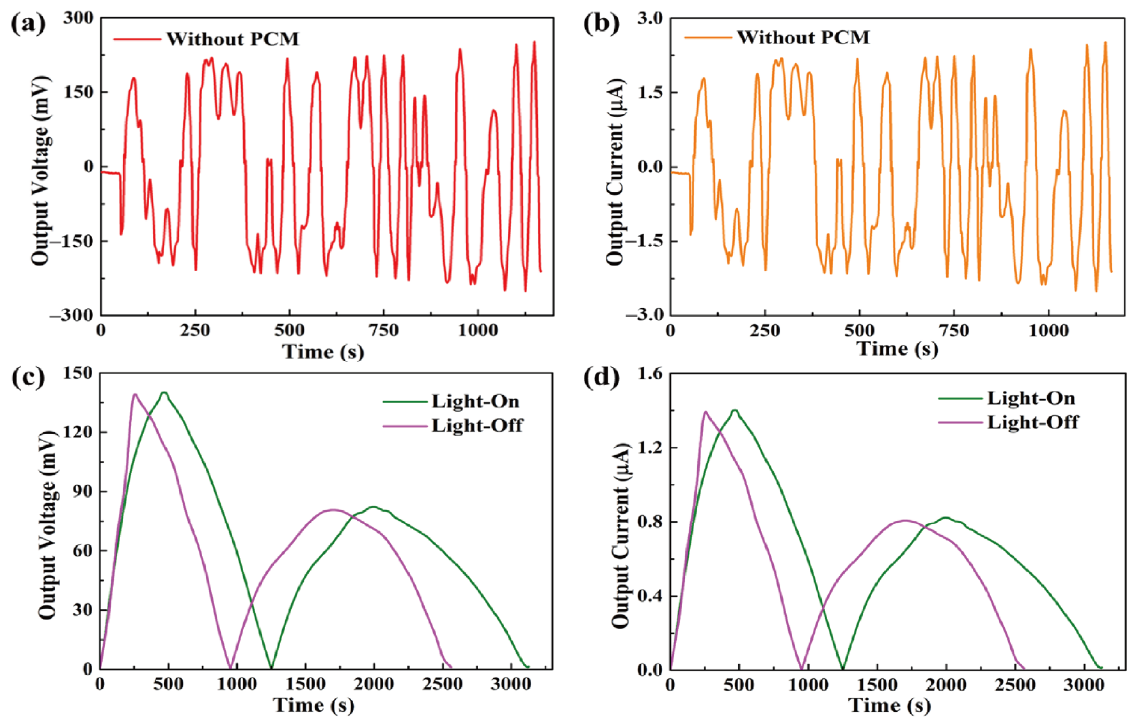
Figure 7. ( a ) Output voltage peak and ( b ) output current peak of the pyro-electrode without PCM. Solar light intensity of 15 mW/cm 2 , showing ( c ) the output voltage peaks during the light-on/off process and ( d ) the output current peaks during the light-on/off process.